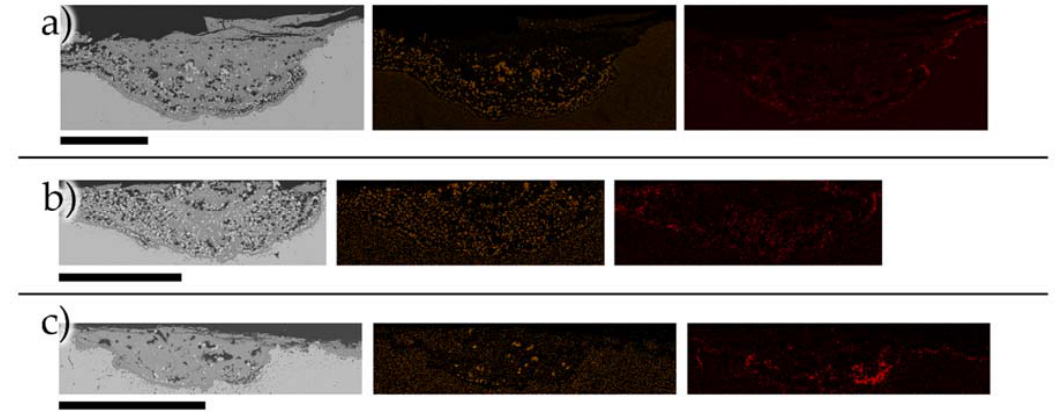
Figure 13. EDS maps for 1275 °C; ( a ) air, ( b ) oxyfuel and ( c ) lean oxyfuel atmospheres. Ni shown in amber, Si EDS map shown in red. Scale bar is 100 µ m.